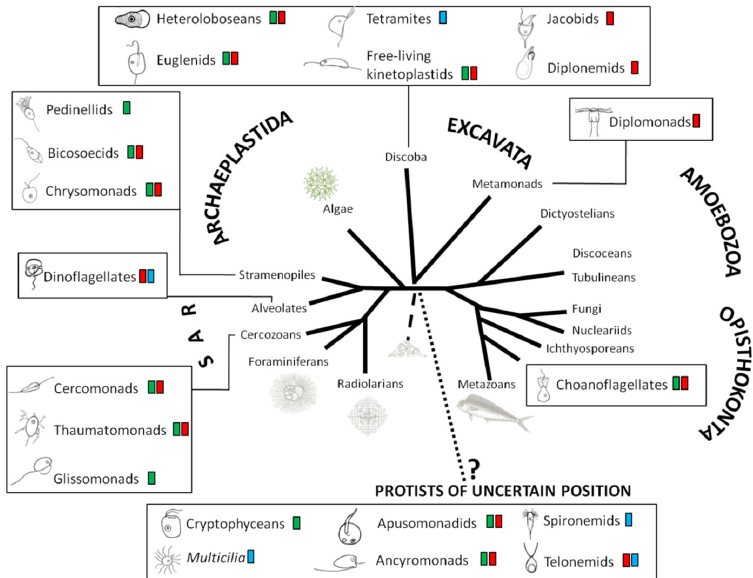
Figure 1. Taxonomic composition of heterotrophic flagellate groups (according to [25]) known from the deep sea. Colors indicate different kinds of quantification and/or qualification methods used for detection: Live ‐ counting (blue), cultures (green), molecular surveys (red) (compilation of literature and own results; scheme derived from [33]).